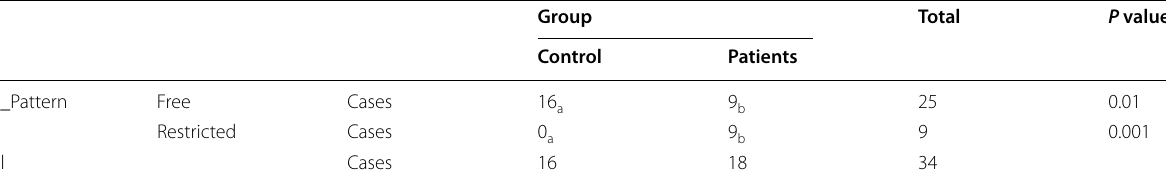
Small subscript letter [a, b] denotes there is a significant difference between both groups. Column proportions differ significantly from each other at the .05 level DWI Diffusion-weighted imaging